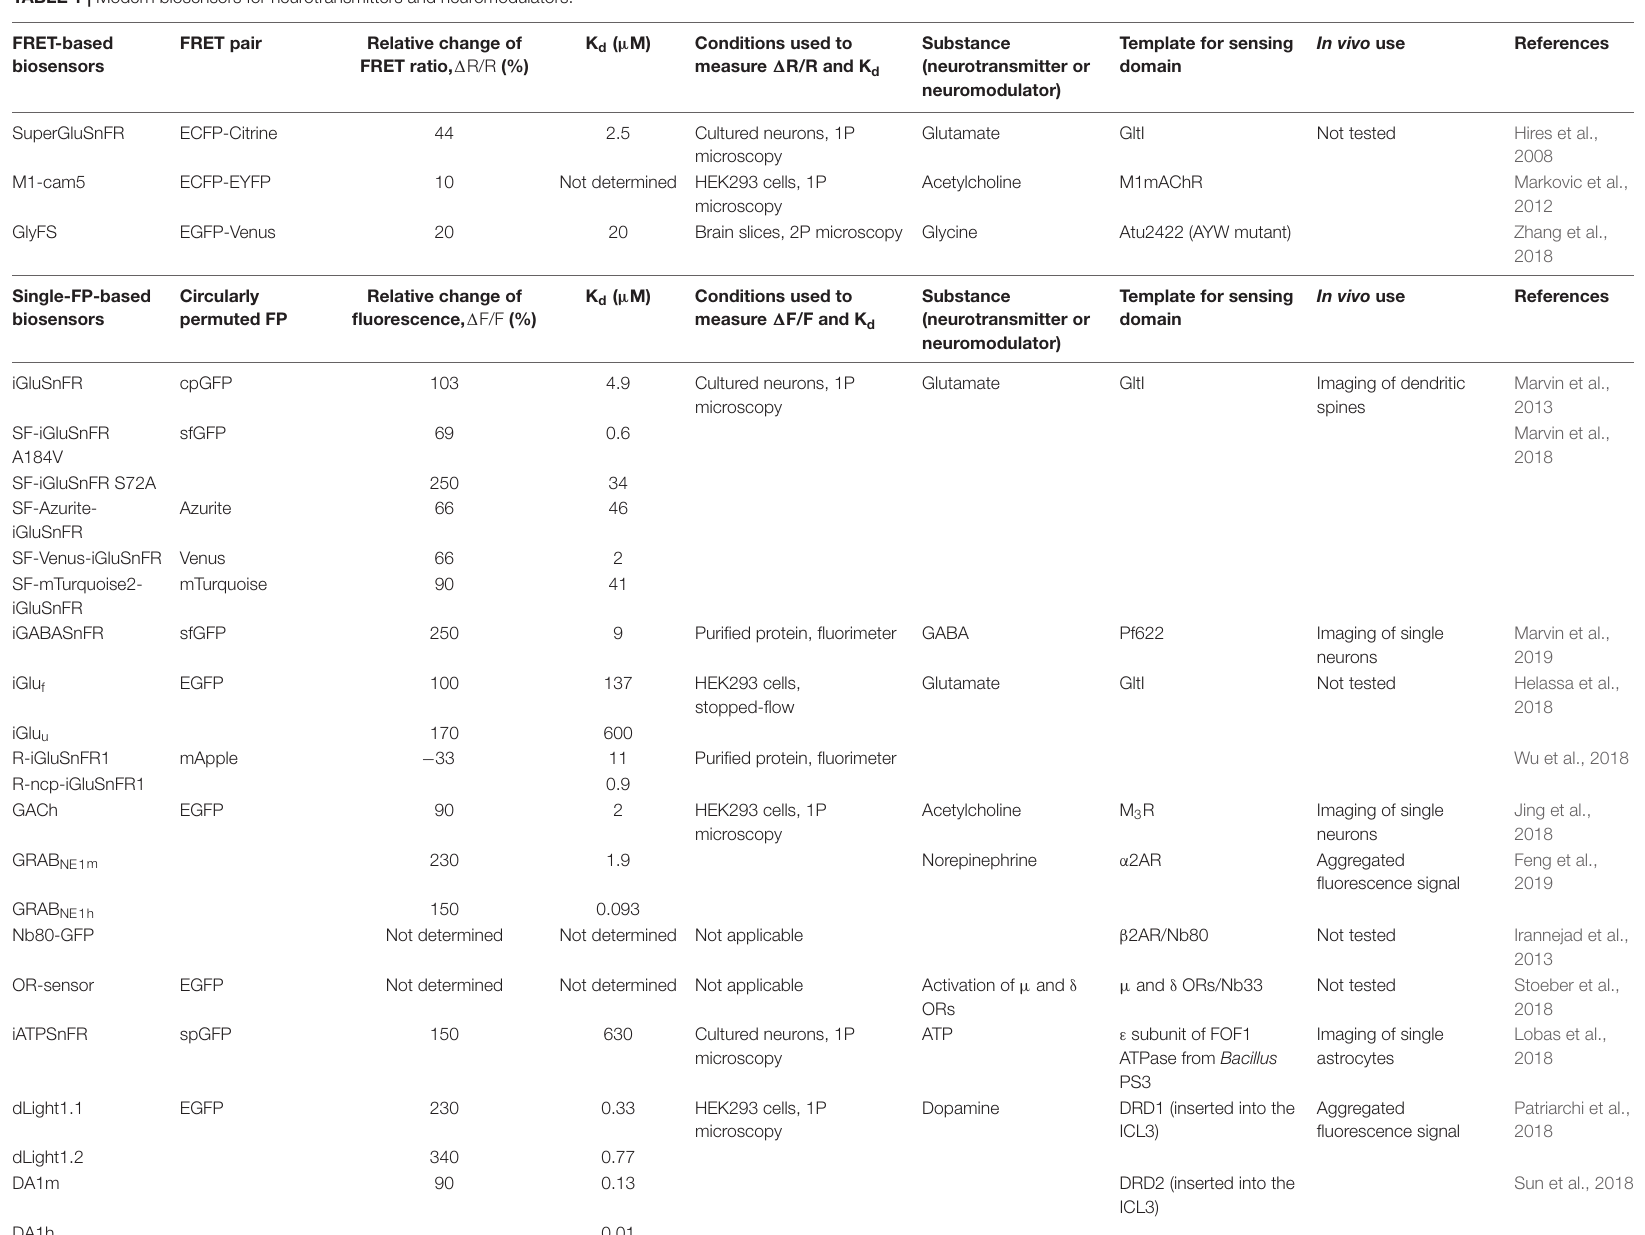
TABLE 1 | Modern biosensors for neurotransmitters and neuromodulators. FRET-based FRET pair Relative change of biosensors FRET ratio, (cid:49) R/R